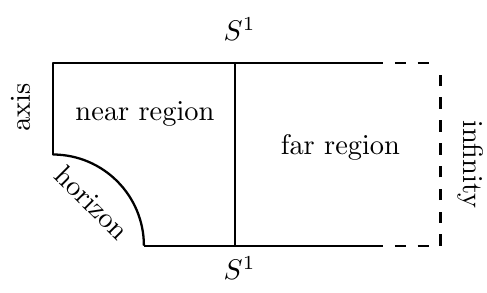
Figure 2 . Sketch of the integration domain for localized black